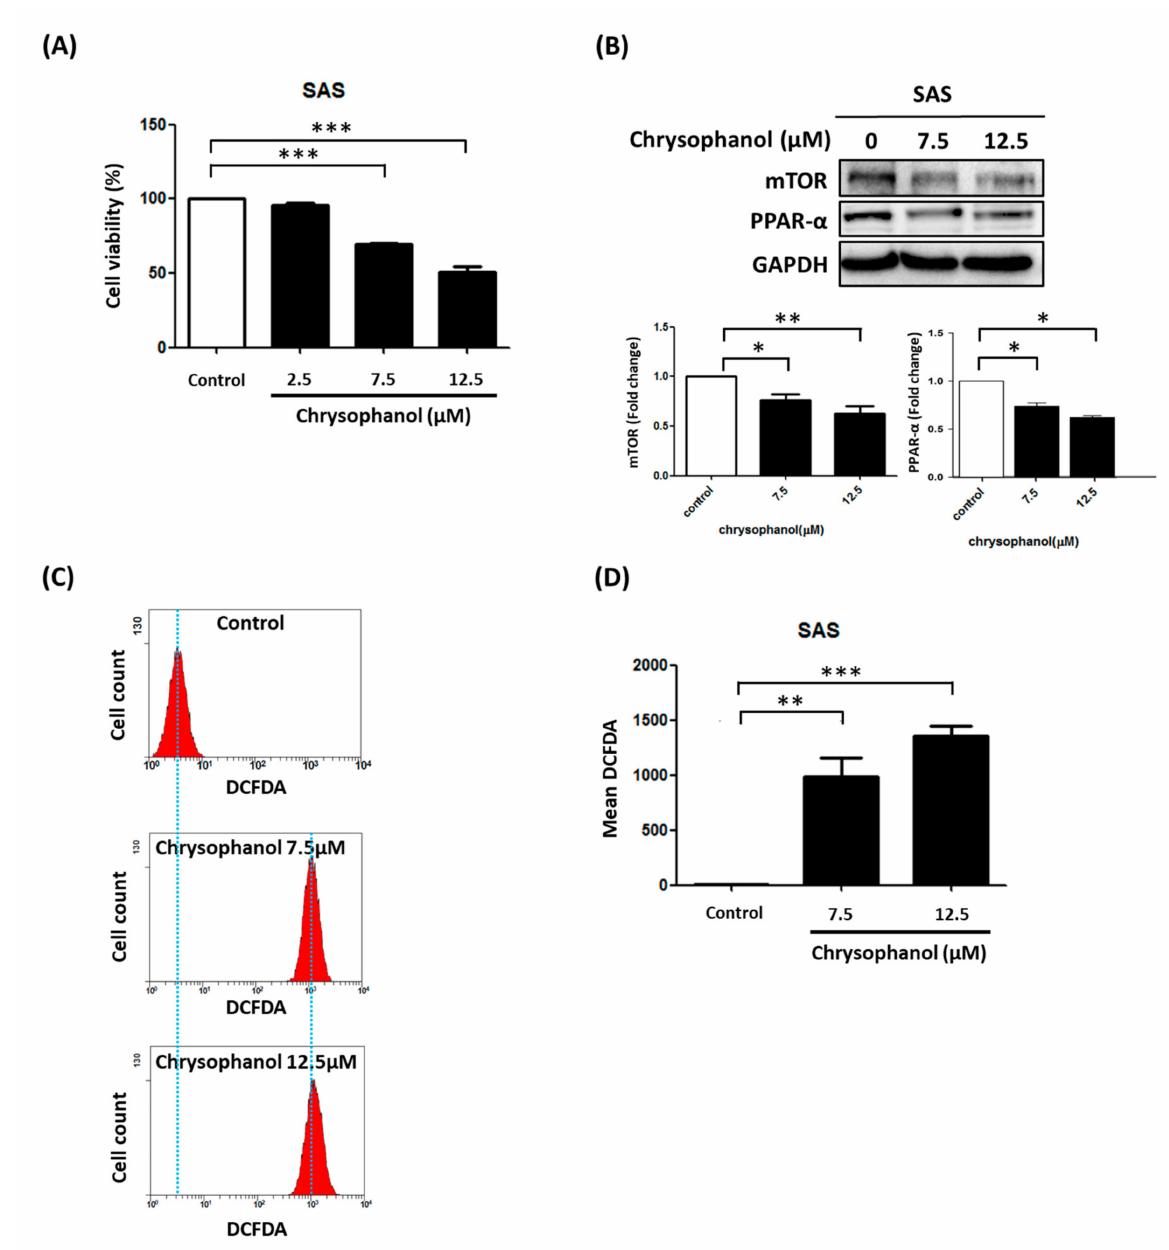
Figure 1. Effect of chrysophanol on cell survival, mTOR/PPAR- α expression, and ROS production in SAS cells. ( A ) WST-1 was used to measure viability of cells in indicated groups. ( B ) Upper panel indicates expression changes of mTOR and PPAR- α proteins in the presence of 0, 7.5, and 12.5 µ M chrysophanol. Lower panel indicates quantitative results of assessing specific proteins using ImageJ. ( C ) Changes in ROS levels (with 10 µ M DEFDA staining) with 0 (control), 7.5, and 12.5 µ M chrysophanol treatment. ( D ) Mean fluorescence intensity was used to measure lipid ROS levels. Three independent replicates were used to calculate standard deviation; n = 3. * p < 0.05; ** p < 0.01; *** p <